Question: What does this figure show? Answer in one sentence.
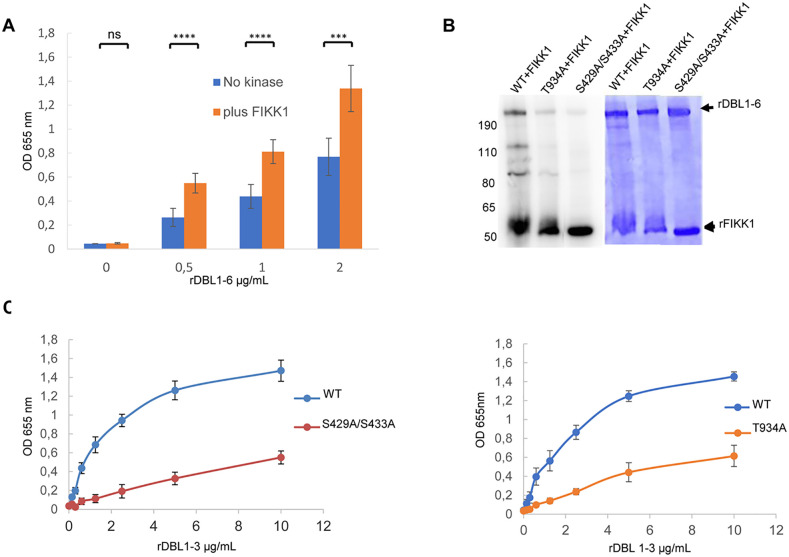
Answer: Phosphorylation increases the binding of VAR2CSA to CSA. Identification and validation of targeted VAR2CSA domains and phosphosites. A . FIKK1 kinase plus ATP increases binding of rDBL1–6 to CSA. 0, 0.5, 1 and 2 μg/mL of rDBL1–6 were preincubated 30 min at 30˚C in kinase buffer supplemented with 10μM ATP with 400 ng or without FIKK1 kinase and added to wells previously coated with CSA. Error bars correspond to SD between 3 independent experiments. Experimental data were analyzed using GraphPad Prism software. Statistics (paired t test; ****p = 0.0001; for 0.5, 1µg/ml and ***p = 0.0005 for 2μg/mL rDBL1–6; CSA chondroitin sulfate A; OD optical density at 655nm; SD standard deviation. B . Effect of mutations T934A and S429A/S433A on rDBL1–6 phosphorylation by rFIKK1 kinase domain. The phosphorylation of the wild-type and mutated rDBL1–6, DBL1–6 T934A and DBL1–6 S429A/S433A proteins were tested in a standard in vitro kinase assay in the presence of [γ-32P] ATP with the recombinant FIKK1 kinase domain. C . Binding assay of wild-type rDBL1–3 and mutated rDBL1–3 S429A/S433A recombinant proteins to CSA-coated plates assayed by ELISA. D . Wild-type rDBL1–3 and mutated rDBL1–3 T934A recombinant proteins were assayed by ELISA for in vitro binding to CSA coated plates. Increasing concentrations of rDBL1–3 proteins at serial dilutions of 0.156 to 10 μg/mL were added to wells previously coated with CSA. Error bars correspond to SD between 3 independent experiments. Each experiment was performed in triplicate.